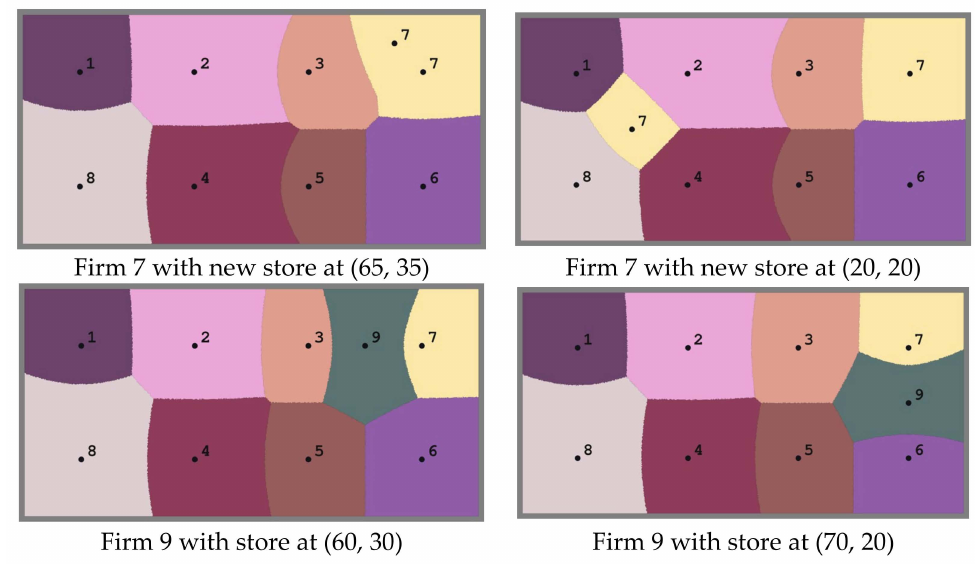
Figure 14. Consumer areas of when new store is added, consumers type